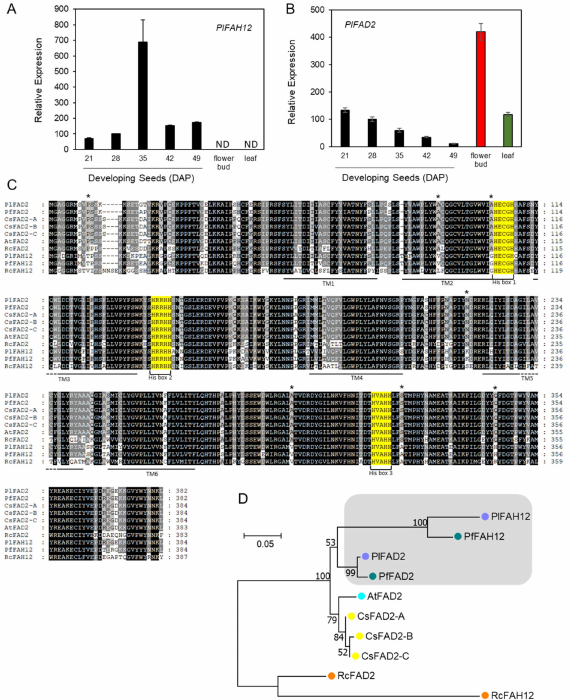
Figure 3. Characterization of PlFAH12s and PlFAD2s. Relative expression of PlFAH12 ( A ) and PlFAD2 ( B ) by qPCR. DAP, days after pollination. ND, not detected. ( C ) Amino acid alignment of FAH12 and FAD2 protein sequences. His-boxes were highlighted in yellow. Putative transmembrane domains (TM) were underlined. Amino acid residues identical in FAD2 but varied in FAH12 were marked with asterisks (*). ( D ) Phylogenetic tree of FAD2, FAH12 proteins from various species. Pl, Physaria lindheimeri; Pf, Physaria fendleri ; At, Arabidopsis thaliana ; Cs, Camelina sativa ; Rc, Ricinus communis . Genbank accession numbers are listed in Supplementary File 6, Table